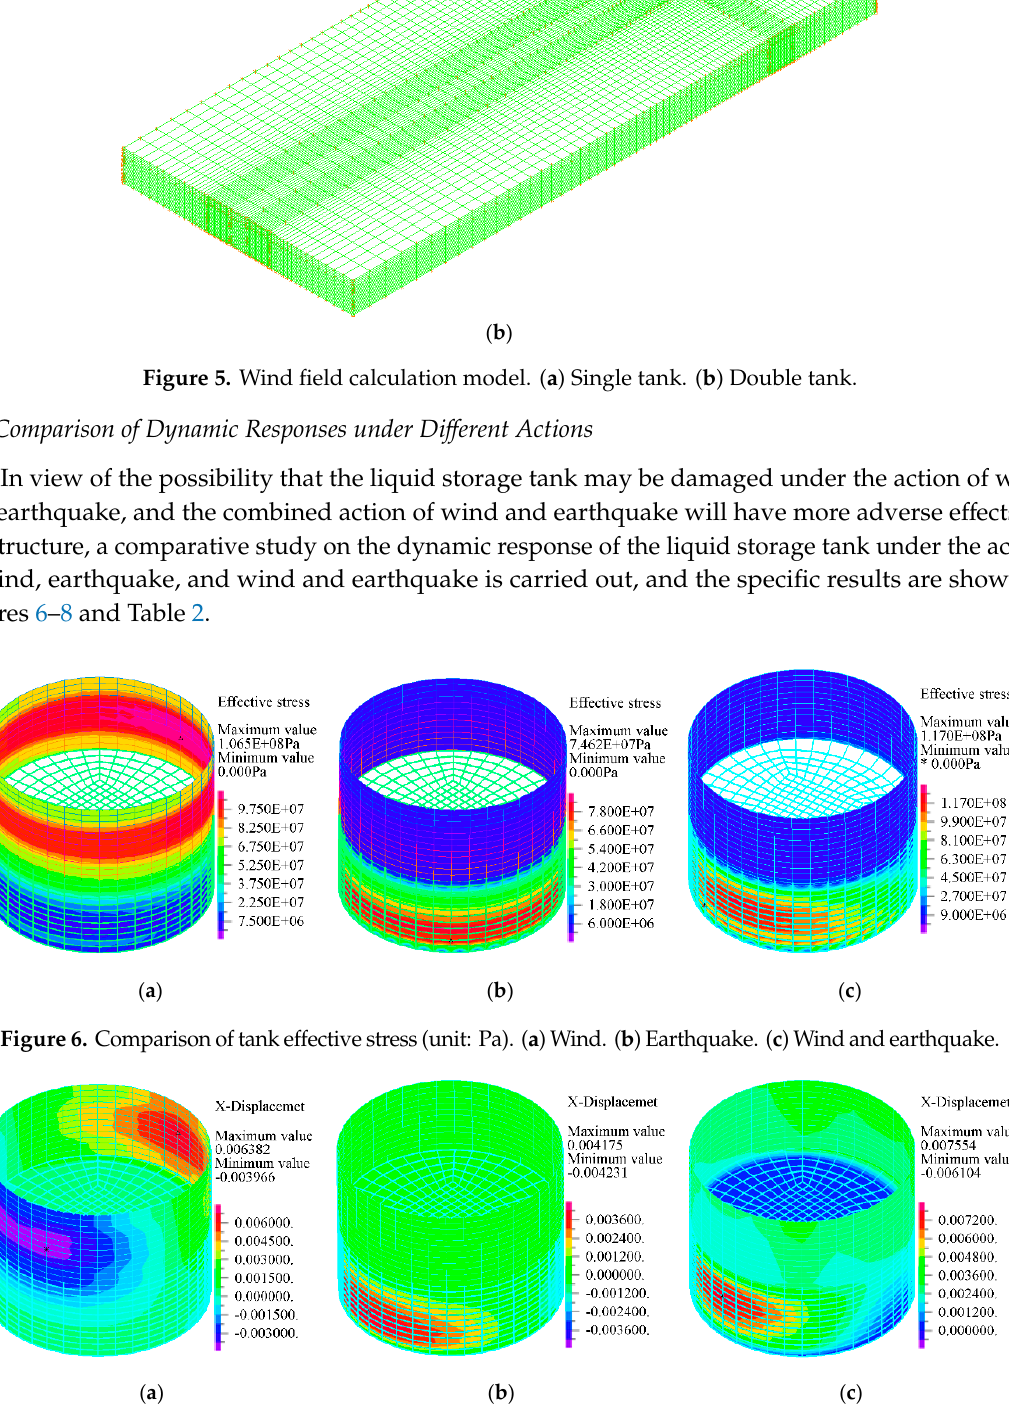
Figure 7. Comparison of tank displacement (unit: m). ( a ) Wind. ( b ) Earthquake. ( c ) Wind and earthquake.